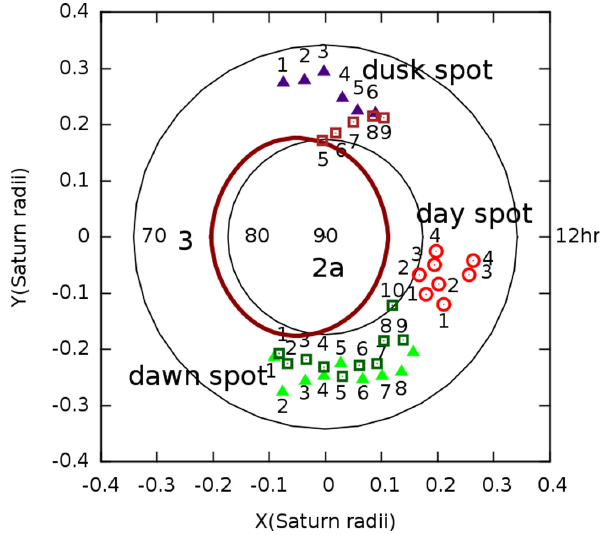
Fig. 10. Southern auroral boundaries for image C, shown in the same format as Fig. 6.